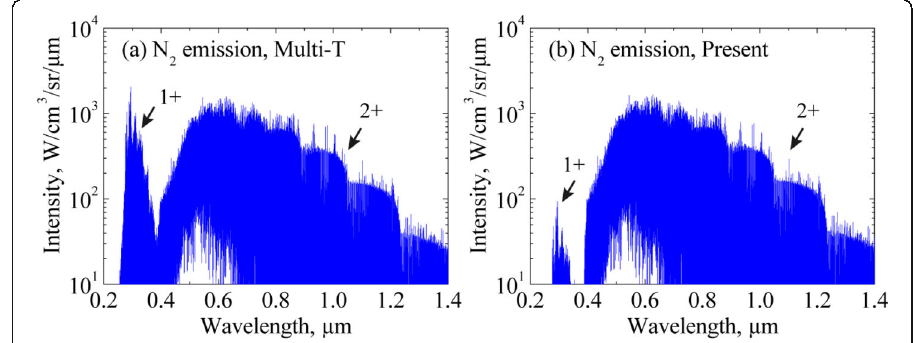
Fig. 2 Emission of N 2 based on the multi-T model ( a ) and the present method ( b